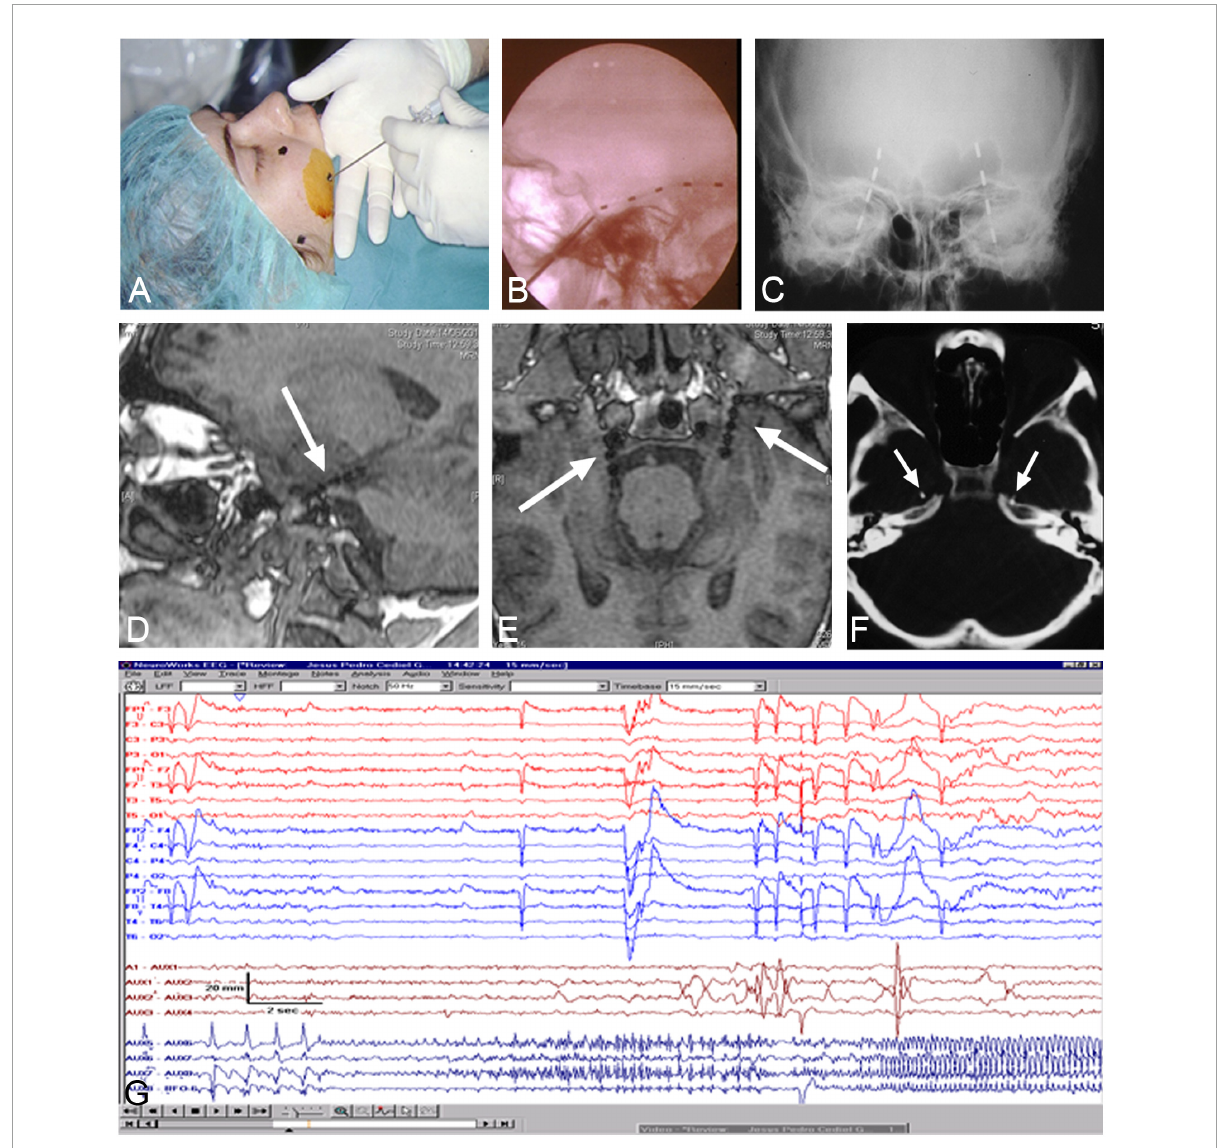
FIGURE1 Foramen ovale electrodes (FOE). (A) Surgical image showing the insertion of the needle into the trigeminal (Gasser) ganglion cistern. (B,C) lateral and antero-posterior X-ray to assess the position of implanted FOE. (D–F) MRI and CT-scan to verify the position of FOE in the ambiens cistern, in contact with the uncus/parahippocampal gyrus (arrows). (G) Video-EEG recording revealing onset of seizures in contacts of the left